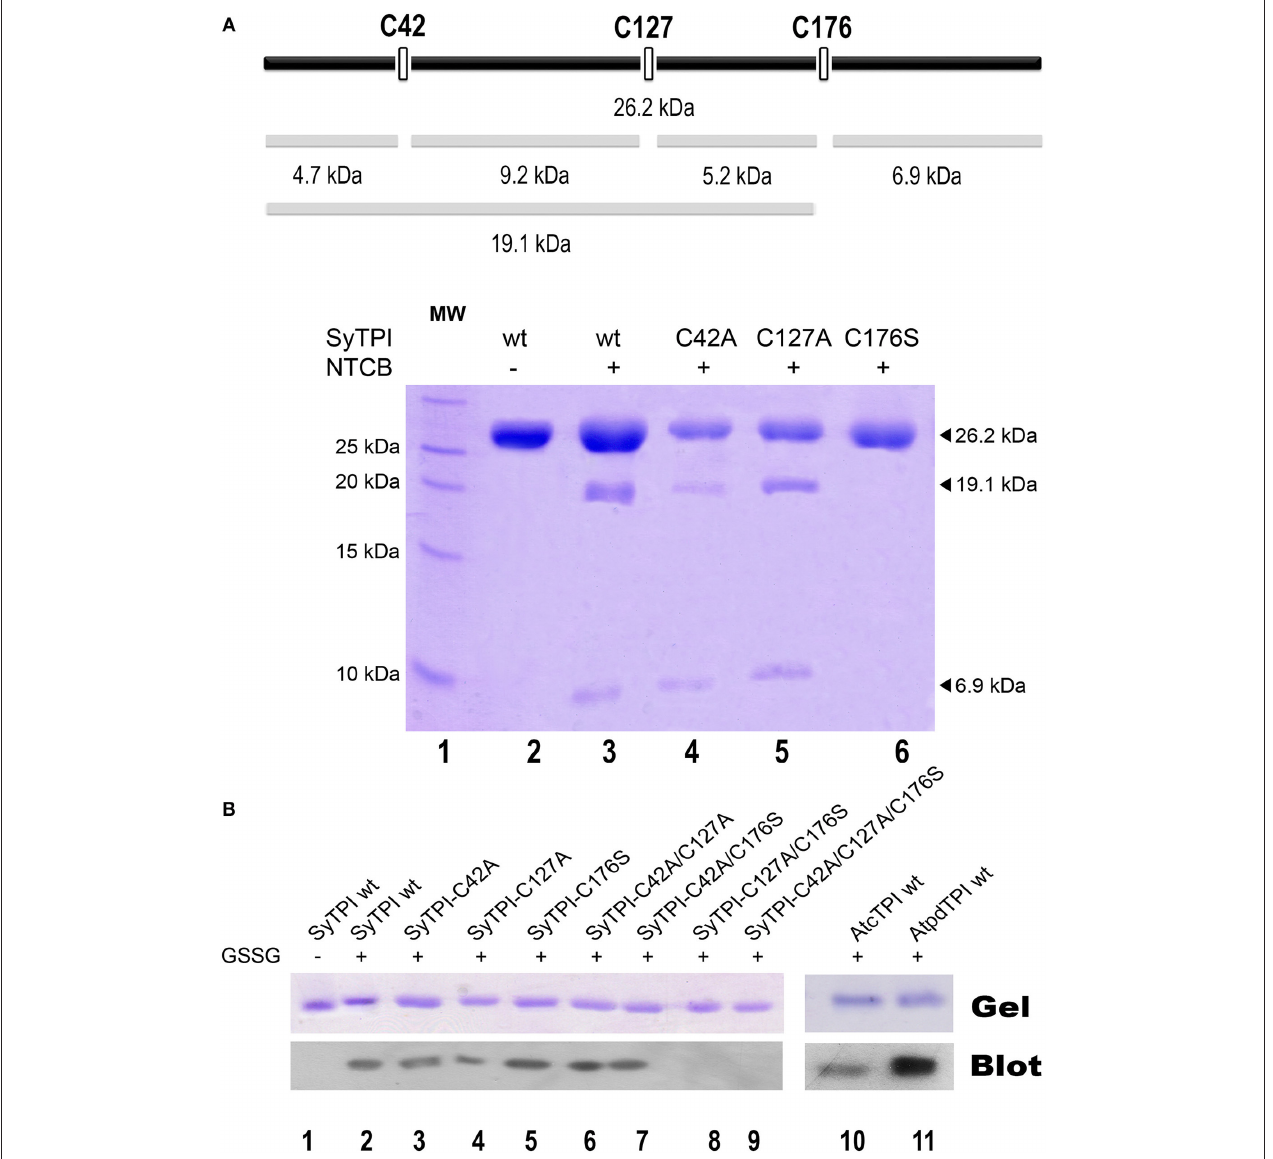
FIGURE 5 | Biochemical determination of exposed cysteines in SyTPI. (A) NTCB cleavage fragments. The bars at the top provide a representation of the possible cleavage sites in SyTPI, samples were digested with NTCB and analyzed. 19.1 and 6.9 kDa NTCB cleavage fragments correspond to cleavage of residue cysteine 176 in wild-type SyTPI. (B) Identification of SyTPI glutathionylation by Western blot. Purified wild-type SyTPI and mutants were incubated in the presence of oxidized glutathione (GSSG). The proteins in the SDS-Page gel were transferred onto a nitrocellulose membrane for Western blot analysis, wild-type AtcTPI and AtpdTPI were used as positive control. Glutathionylation was detected for the wild-type SyTPI, single mutants and C42A/C127A and C42A/C176S double mutants (lanes 2–7) and positive control proteins (lanes 10–11), whereas no signal was detected for the double C127A/C176S and triple C42A/C127A/C176S mutant (lanes 8 and 9).